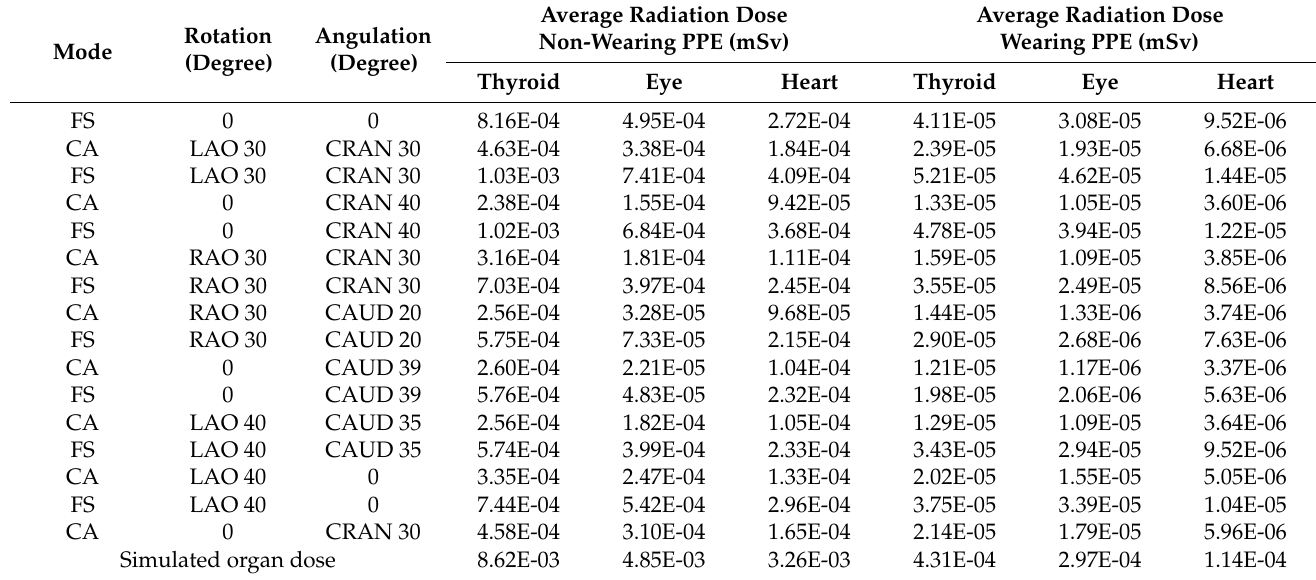
Table 3. The simulated occupational organ dose for cardiac angiography with and without PPE.